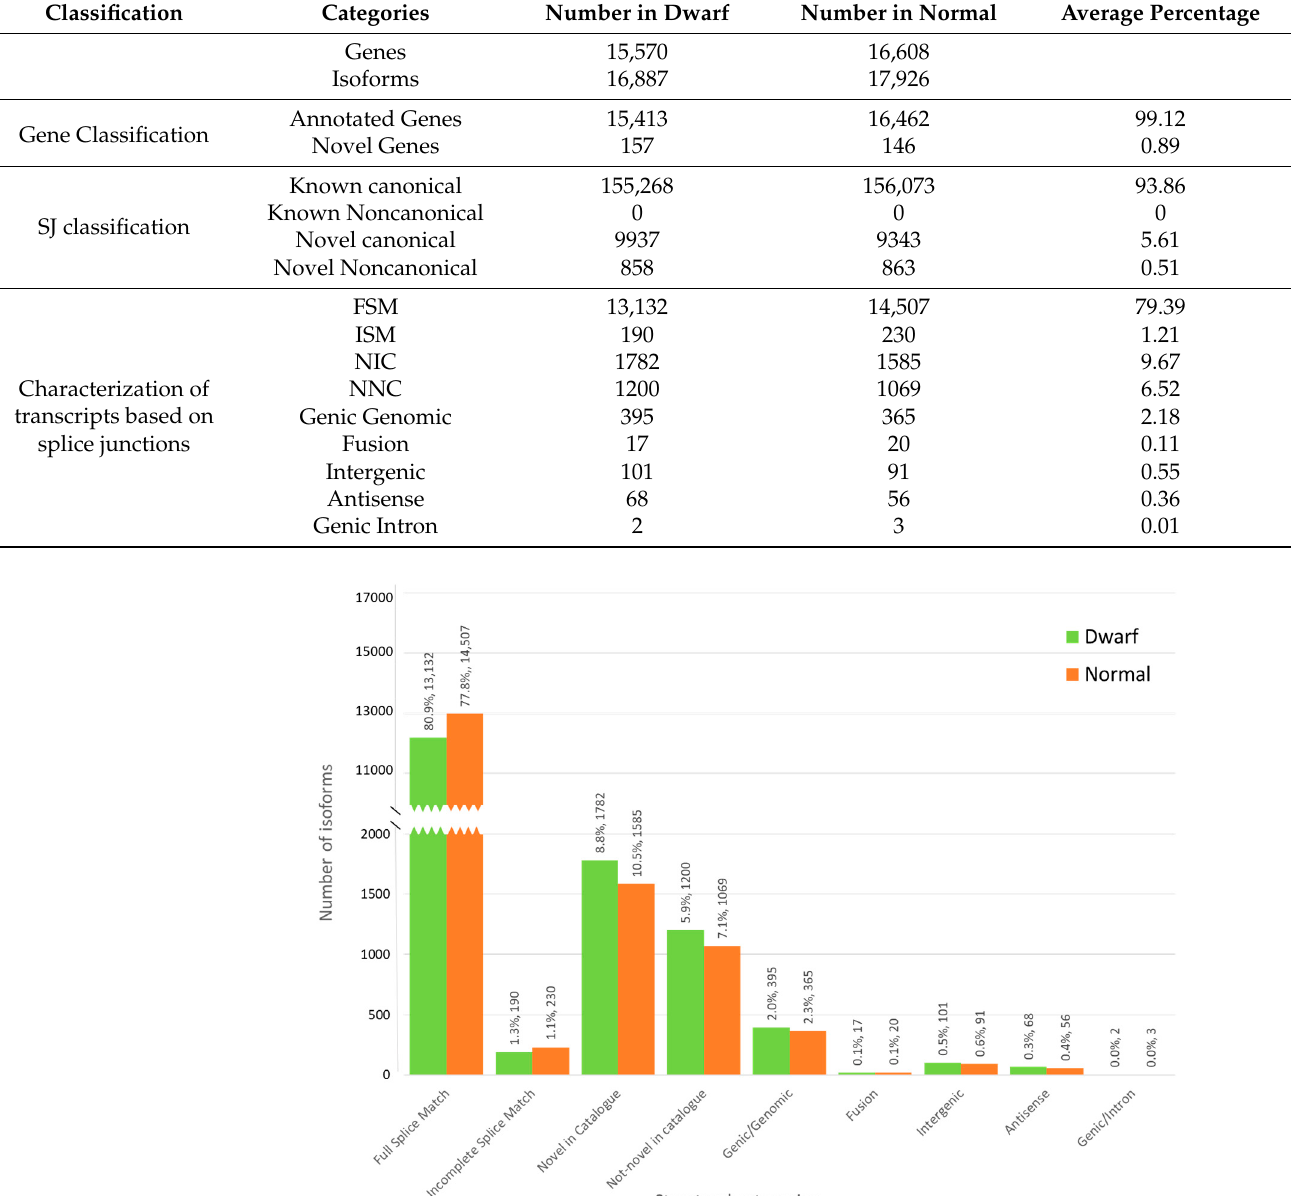
Table 2. Distribution of transcripts and splice junctions (SJs) in the structural categories in dwarf and normal soybean.